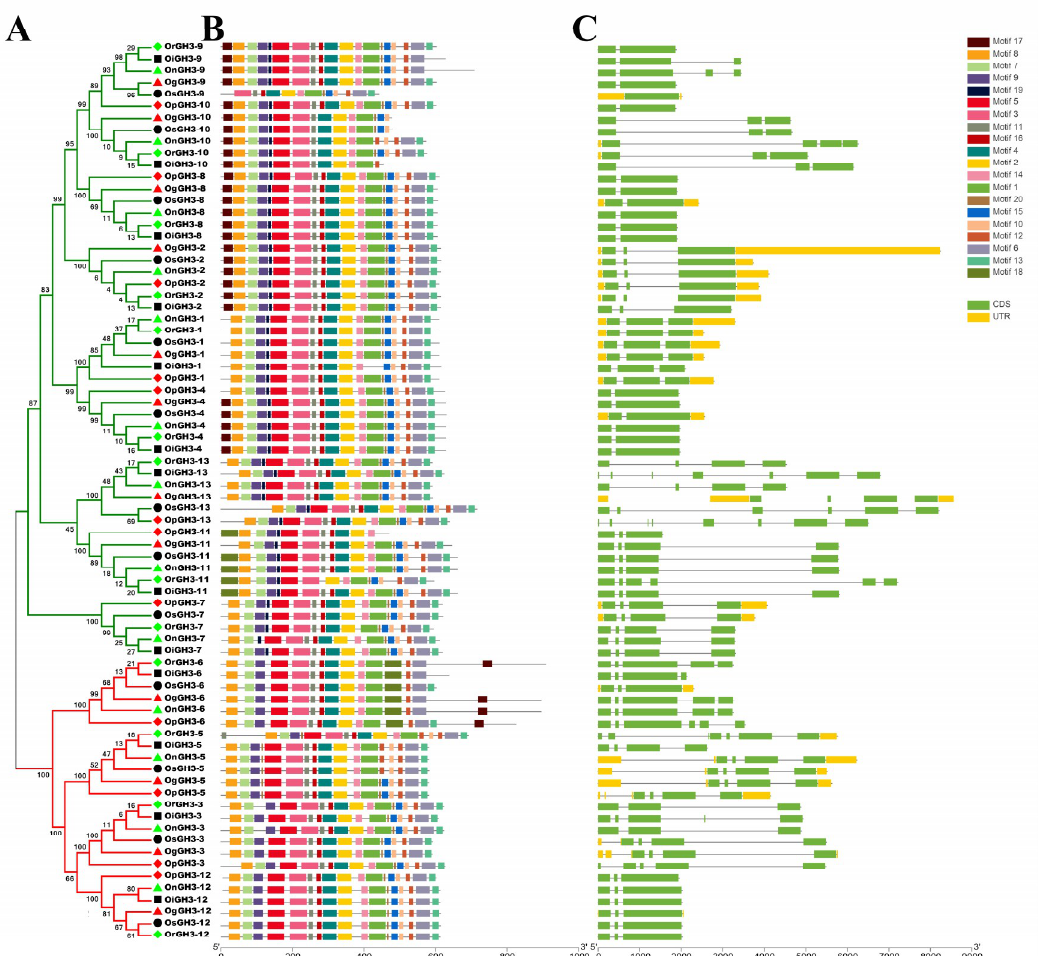
Figure 2. The phylogenetic tree ( A ), motif compositions ( B ), and exon/intron structure ( C ) of the GH3 genes in six Oryza species/subspecies. ( A ) Sequence alignments and the NJ-Phylogenetic trees were made using ClustalW and MEGA 6.0, respectively. A bootstrap number (1000 replicates) is adopted. The red and green colors in the phylogenetic tree represent group1 and group2, respectively. ( B , C ) The widths of the grey bars represent the relative lengths of genes and proteins. The green boxes and grey lines display exons and introns, respectively.